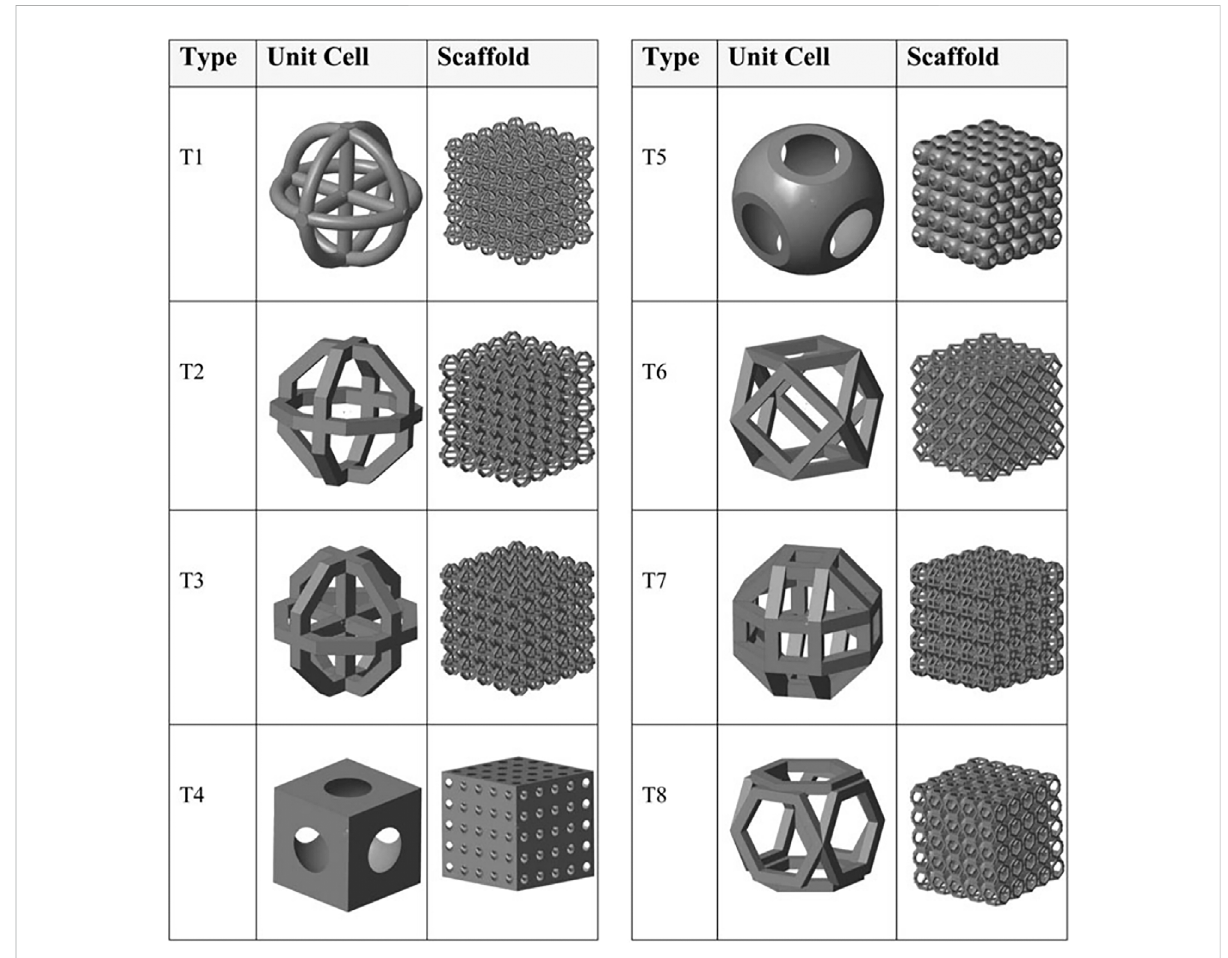
FIGURE 5 Models of all (eight) types of unit cells and scaffolds. Copyright 2016, Mary Ann Liebert.